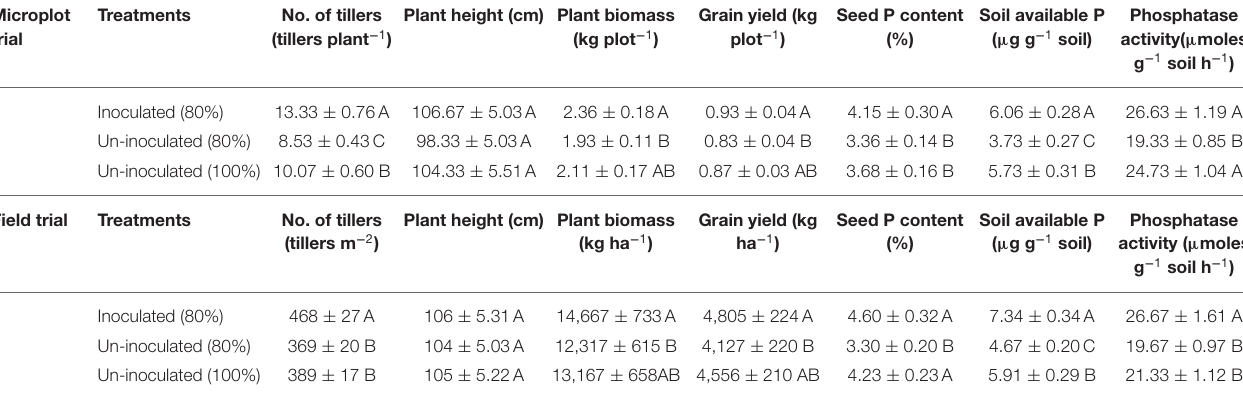
TABLE 3 | Effect of Filter mud bioformulation and PSB consortium on plant growth and yield of wheat in microplots and field conditions. Microplot